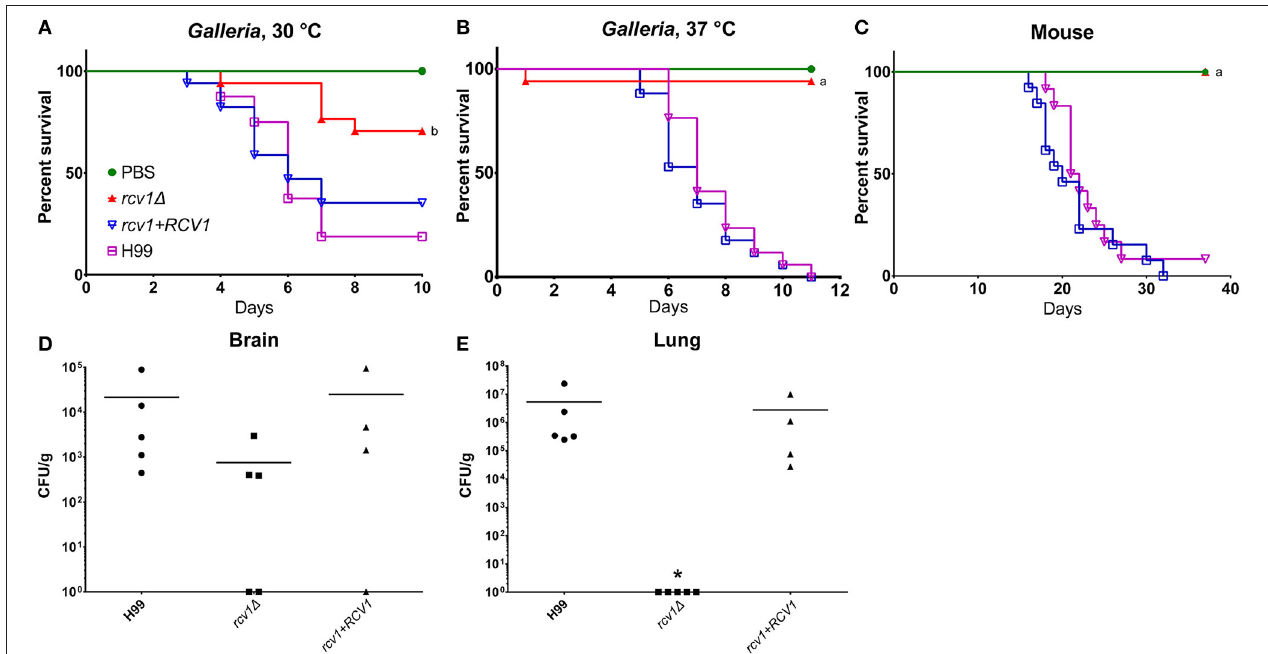
FIGURE 5 | The rcv1 ∆ strain is hypo- or avirulent in vivo . (A–C) Survival curves in caterpillar and murine models. G. mellonella were infected with 10 4 yeast cells per individual, whereas BALB/C mice were infected with 2 × 10 5 cells each. The “a” indicates statistical difference relative to H99 and rcv1 + RCV1 , and “b” indicates statistical difference relative to all the other groups (log-rank test, p < 0.001). (D,E) Fungal burdens in brain and lung from mice at day 12 of infection. Groups were compared using the Kruskal-Wallis test. The asterisk indicates significance ( p < 0.05) relative to the other two groups. Bars,